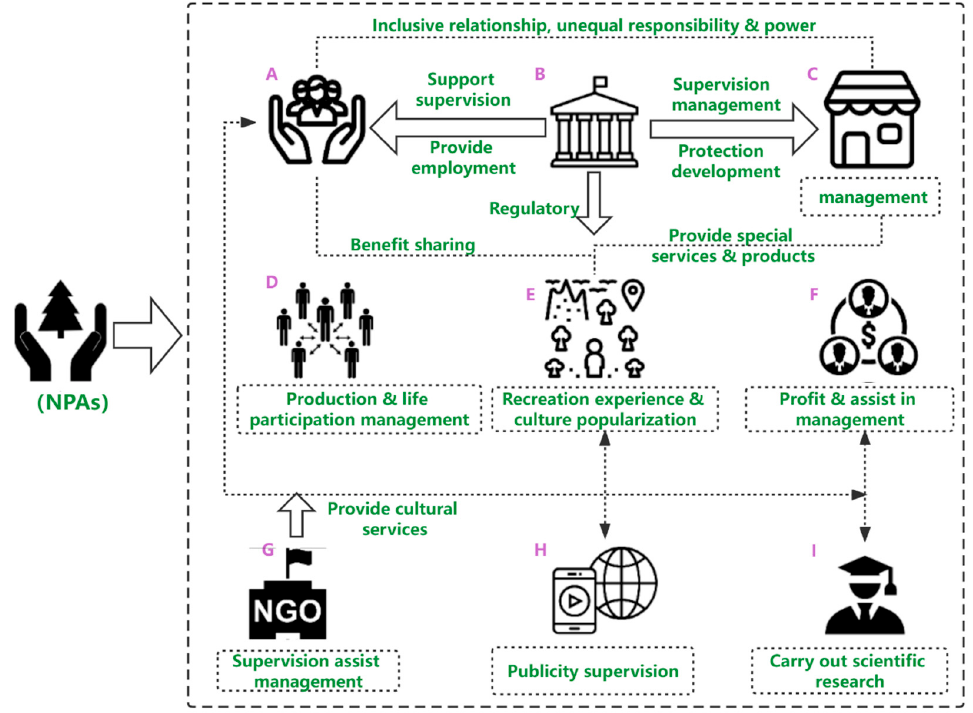
Figure 7. Map of the relationship between stakeholders in NPAs. ( A )—community residents; ( B )—government department; ( C )—concessionaire; ( D )—social public; ( E )—social public; ( F )—other operating investors; ( G )—non-governmental organization; ( H )—news media; ( I )—experts and scholars.